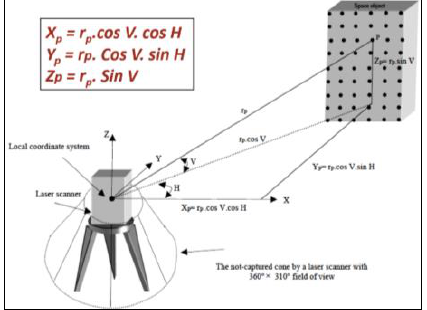
Figure 3. How Terrestrial Laser Scanner Works (source: Zulkepli, 2015)